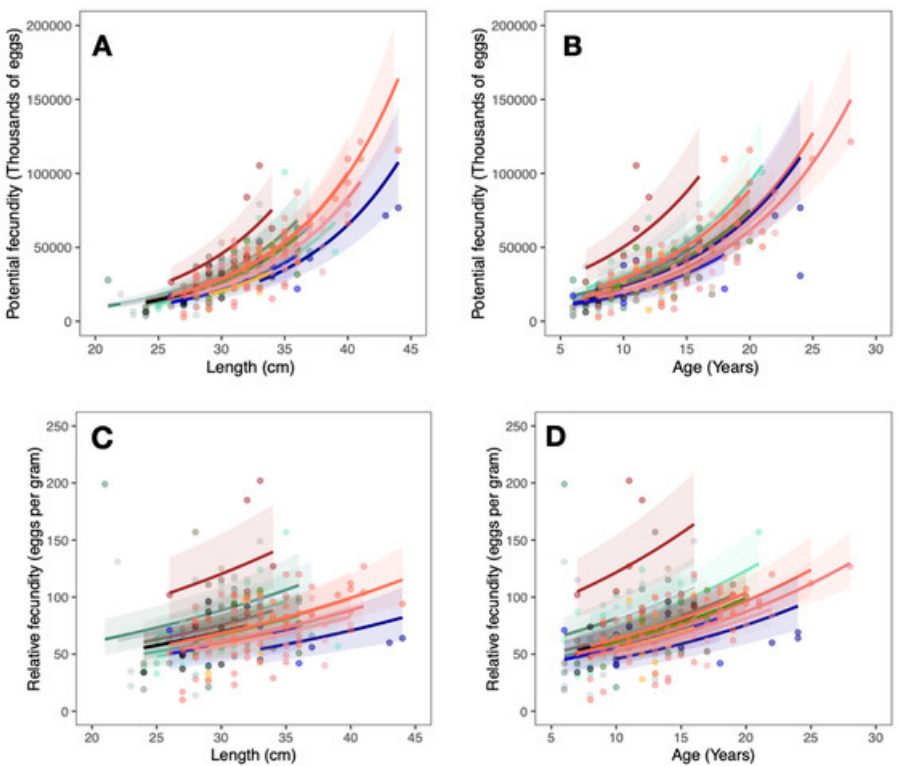
Fig. 4. – Interannual variation of the relationships between potential fecundity by length (A) and age (B), and between relative fecundity by length (C) and age (D) of S. fasciatus on the Flemish Cap between 1996 and